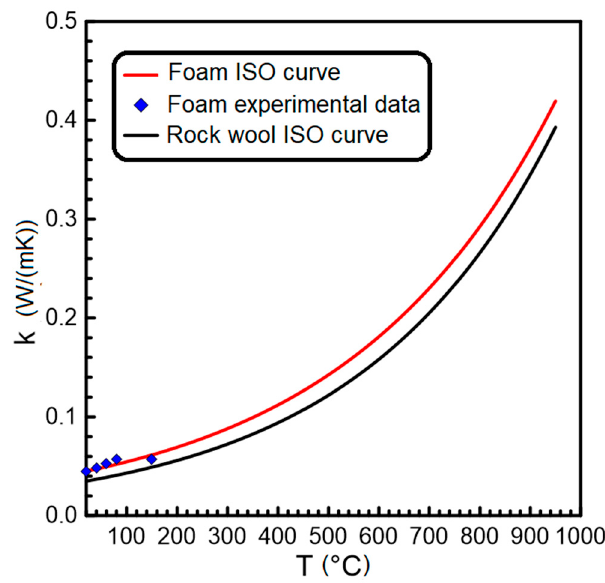
Figure4. Thermalconductivityvs. temperature; Figure 4. Thermal conductivity vs. temperature; comparison between ISO curves and experimental data.